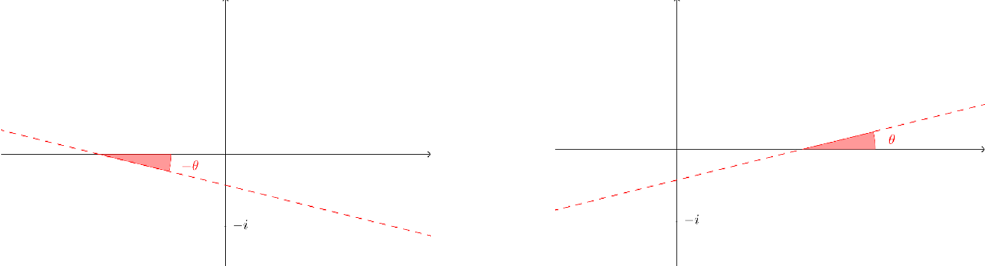
Figure 20 . Choice of integration contour for the Mordell integrals, shifted and rotated by a small angle with respect to the real axis. Left: contour for (cid:9) + , rotated by a negative angle (cid:0) (cid:18) < 0. Right: contour for (cid:9) (cid:0) , rotated by a positive angle (cid:18) >